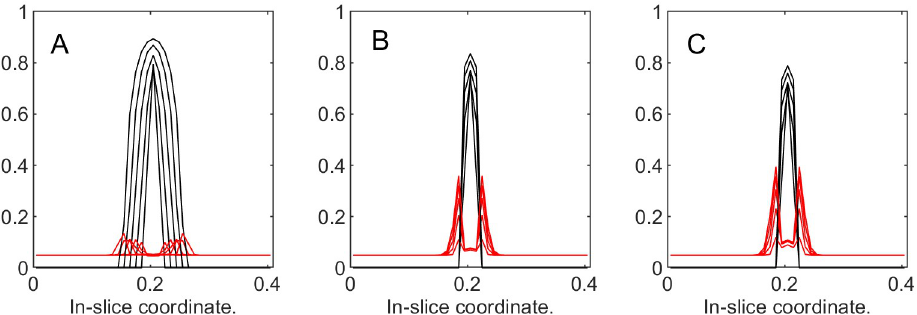
Fig 17. Tumor and ECM dynamics for various ECM active response coefficients. “Slices” at times 100, 200, ... , 500. A: α = 0. B: α = 1. C: α = 2. Note that as α increases, tumor becomes noticeably